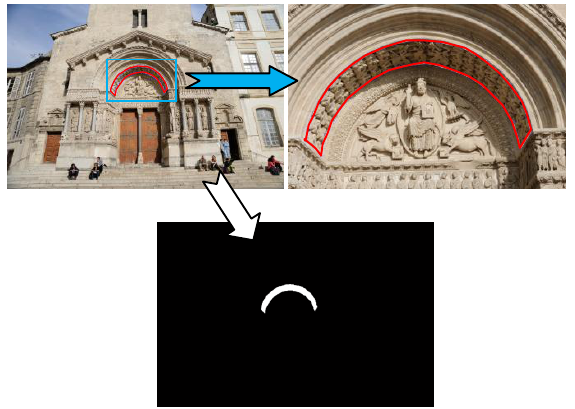
Figure 7: Definition of the ROI (up) and extracted mask (down)